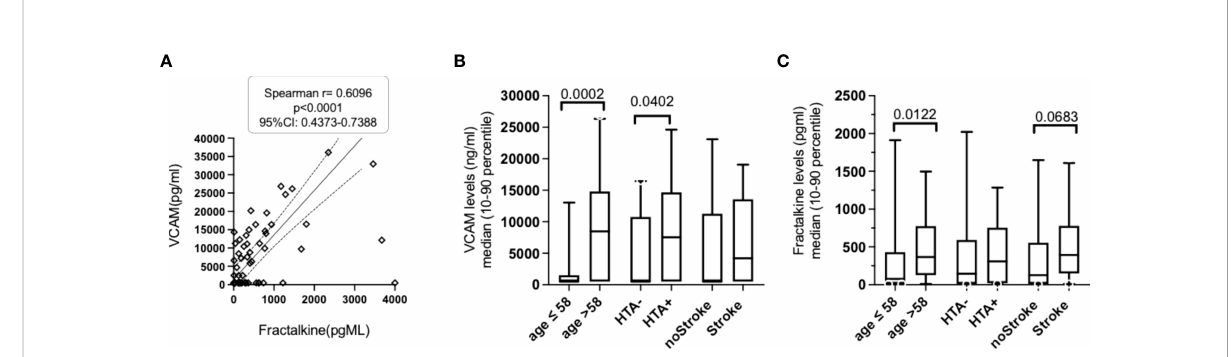
FIGURE 3 Analysis offractalkine and VCAM levels association with ECD donor-related risk factors. (A) . VCAM levels were signi fi cantly correlated with the fractalkine levels evaluated in the perfusion fl uid of ECD donors. (B) . Comparative analysis of VCAM levels in perfusion fl uid of transplant strati fi ed according to three donor-related risk factors (donor age > 58.5 years, HTA and donor stroke) revealed that VCAM levels were signi fi cantly higher in aging ECD donors (> to the median 58 years value observed in the cohort and in conservation fl uids of transplant from donors with hypertension (HTA). Signi fi cant p values ( p <.05) or trends for signi fi cance were (p < .2) resulting from non-parametric Mann-Whitney test comparison of evaluated soluble biomarkers median levels are indicated. Non-signi fi cant values >.2 are not reported. (C) . Comparative analysis offractalkine levels in the perfusion fl uid of transplants